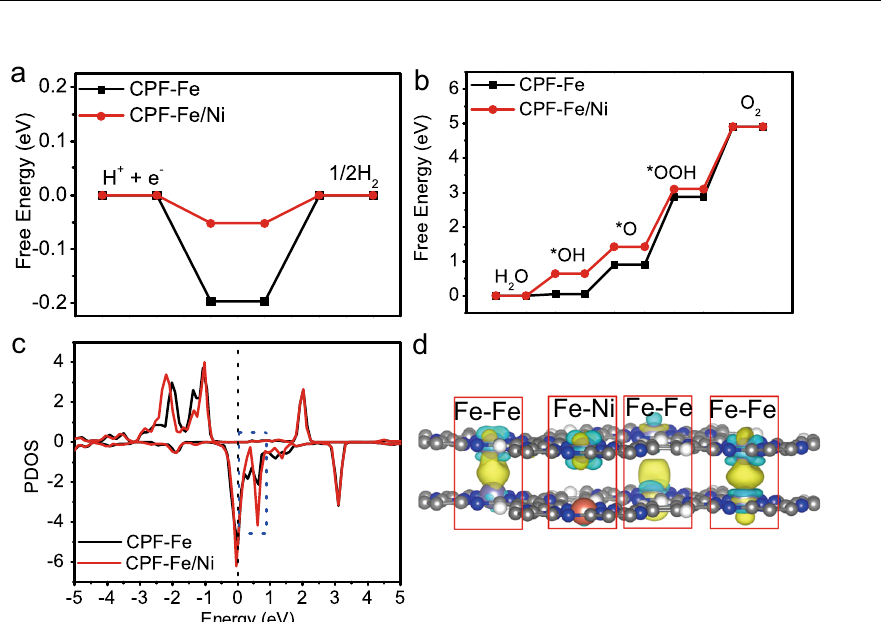
Fig. 5 | Theoretical calculations. The free energy curves of a HER and b OER on CPF-FeandCPF-Fe/Ni,respectively; c ThepartialdensityofstateforFe-3dinCPF-Fe and CPF-Fe/Ni; d The differential charge for Fe-Fe and Fe-Ni site in CPF-Fe/Ni. The